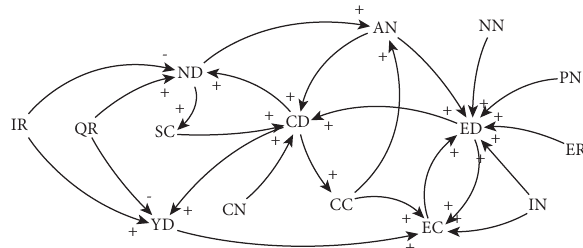
Figure 1: Causal relationship of infection